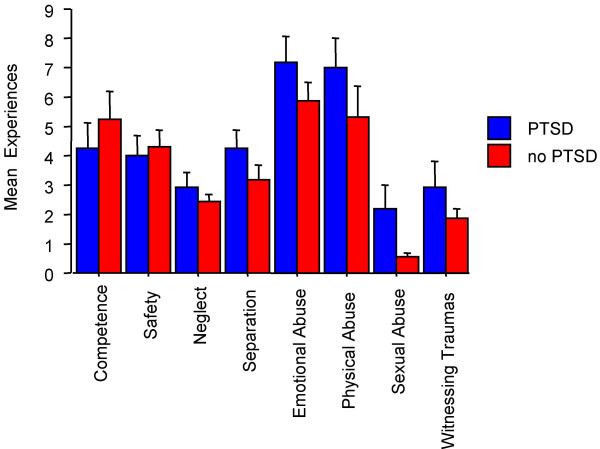
Average number of experiences separately for the 11 domains assessed by the TAQ and separately for patients with (blue) and without (red bars) current PTSD.